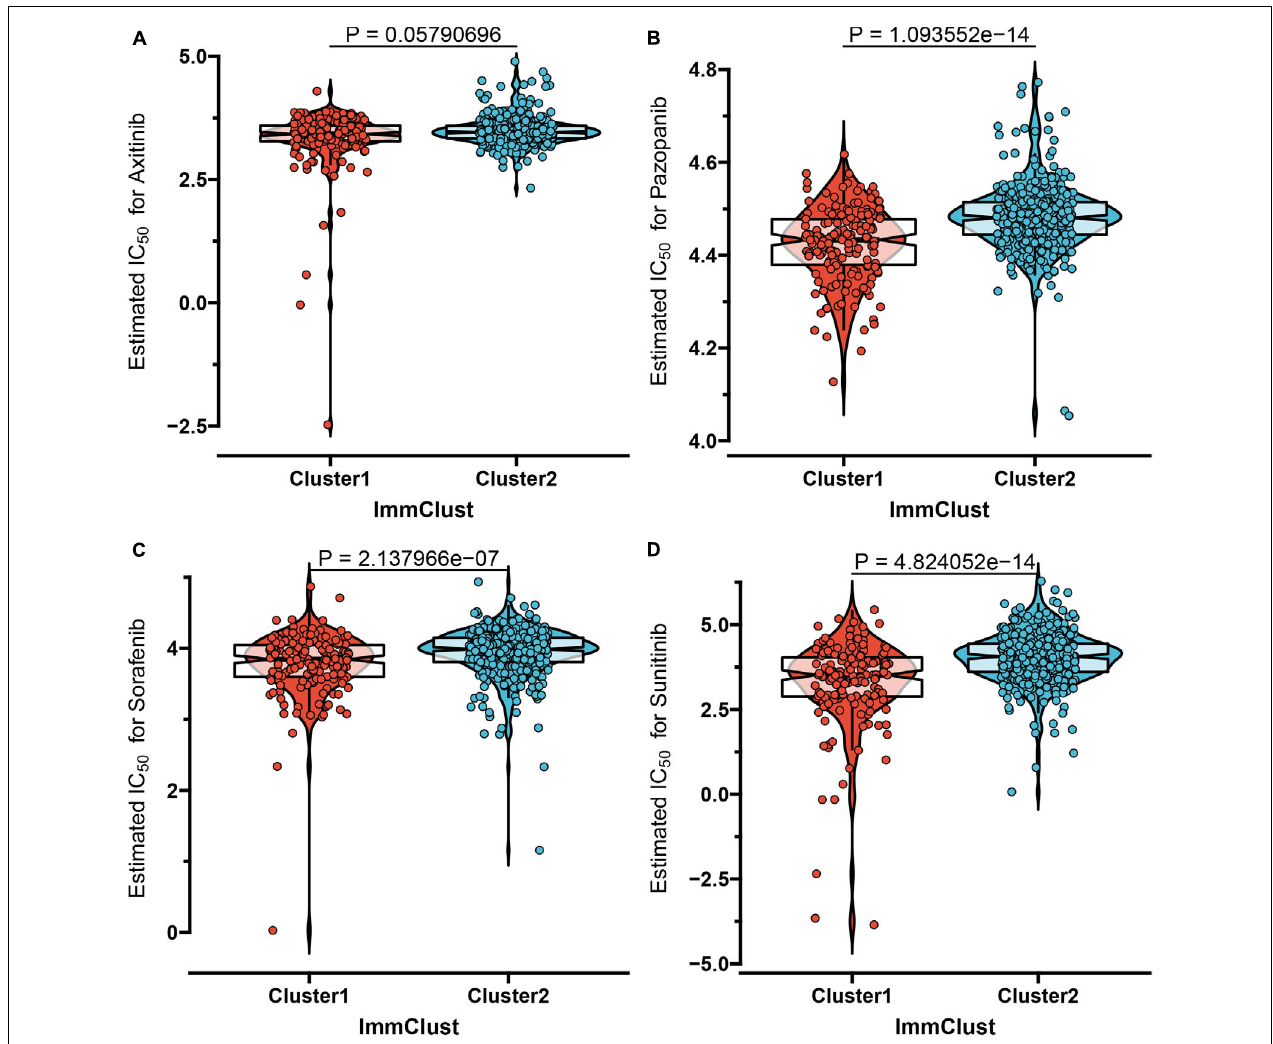
FIGURE 4 | The IC 50 values of four chemo drugs in the two molecular subtypes of ccRCC including Axitinib (A) , Pazopanib (B) , Sorafenib (C) , and Sunitinib (D) .